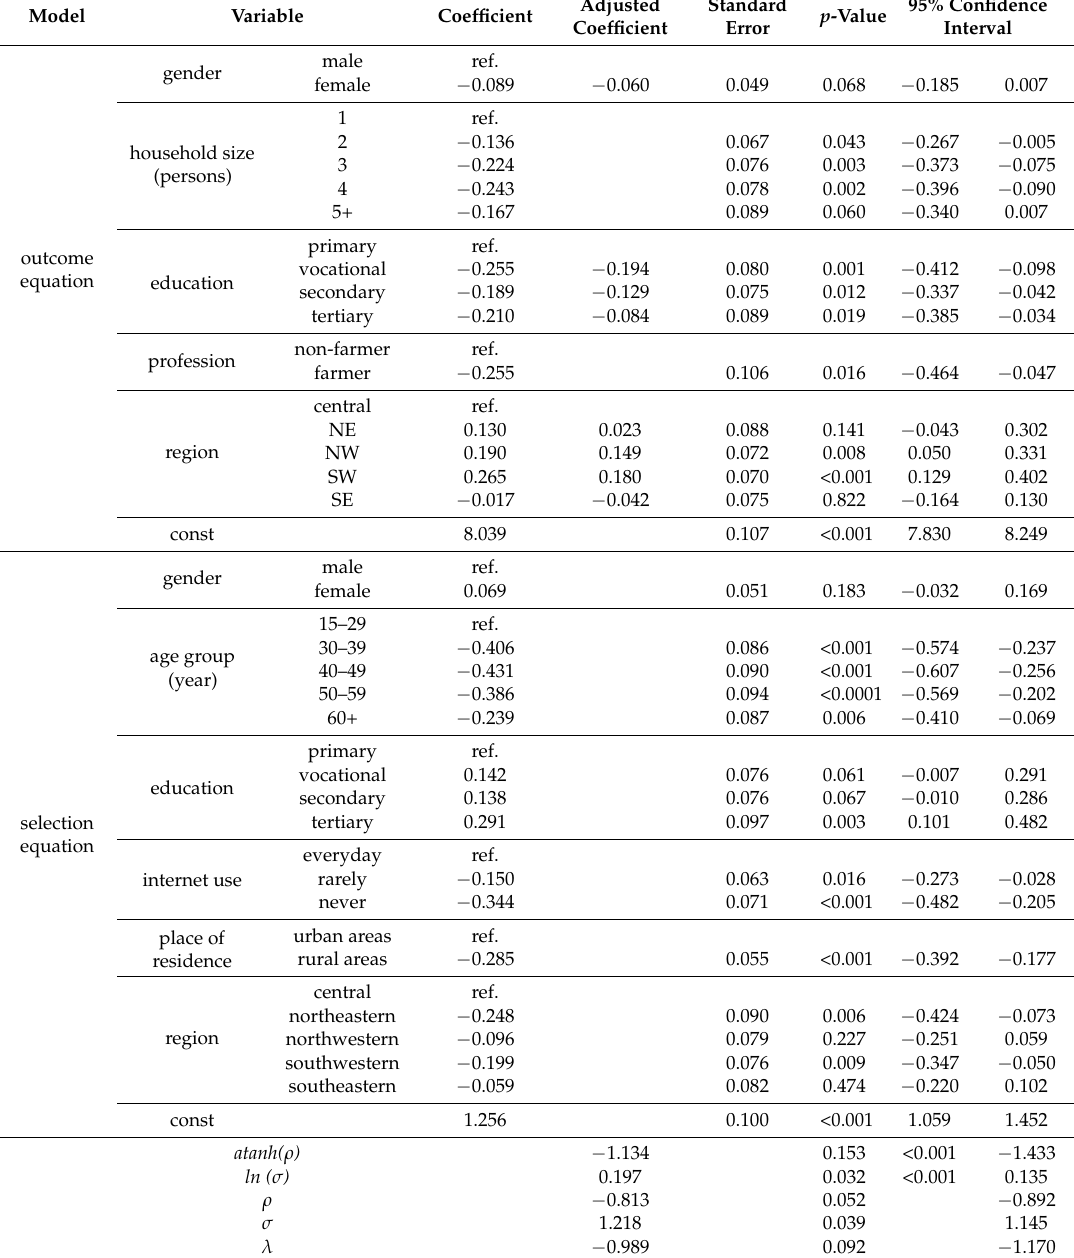
Table 4. Impact of living in a rural area on physical activity—estimates of Heckman selection model. Model